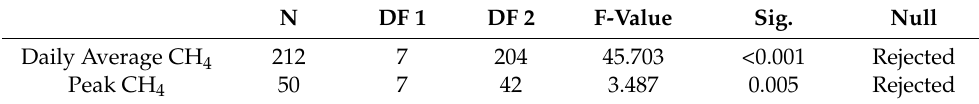
Table 3. Full experiment ANOVA of treatment differences for biogas quality. (There were 50 total different AD reactors jars for this study. The peak CH 4 measurement for each individual jar reactor is reflected in this table. The daily average CH 4 concentration for a treatment in a particular incubation round was assessed within 212 sampling sessions, which is also reflected here in Table 3).